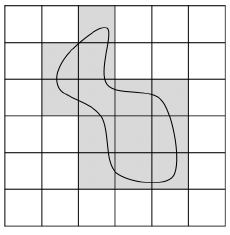
Figure 5. An example of a grid